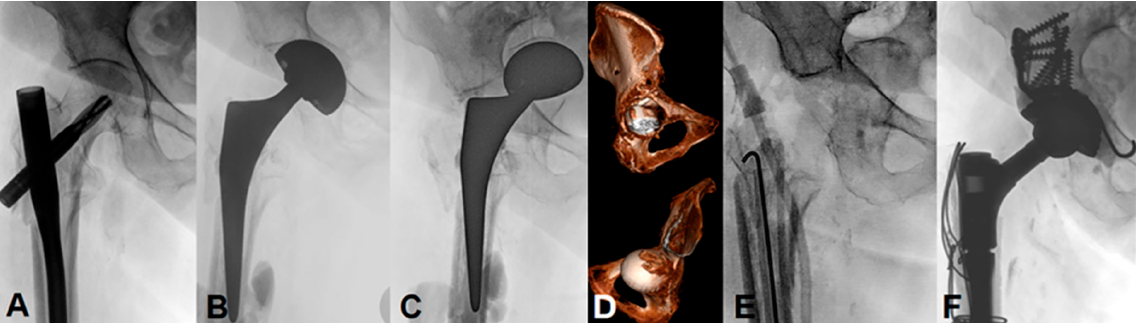
Figure 3. Anteroposterior radiographs and computed tomography (CT) images of an 80-year-old woman with ( A ) a symptomatic non-union of a pertrochanteric fracture on the right side, ten months after the osteosynthesis with a femoral nail. ( B ) Postoperative radiographic view two days after a THA with an interruption of the ilioischial and iliopectineal lines. ( C ) Atraumatic acetabular fracture after partial weight-bearing four weeks postoperative with a complete intrapelvic protrusion of the acetabular component. ( D ) A corresponding CT scan was acquired for evaluation of the fracture pattern (AAOS IIA) and the preoperative planning. ( E ) Two-stage revision with the removal of the femoral and acetabular components and the placement of an antibiotic-cement spacer due to the concomitant diagnosis of chronic prosthetic joint infection. ( F ) Reconstruction of the acetabulum using a dual mobility acetabular component, a structural and morselized bone graft, and a Ganz reinforcement ring, six months after the first stage of the revision.